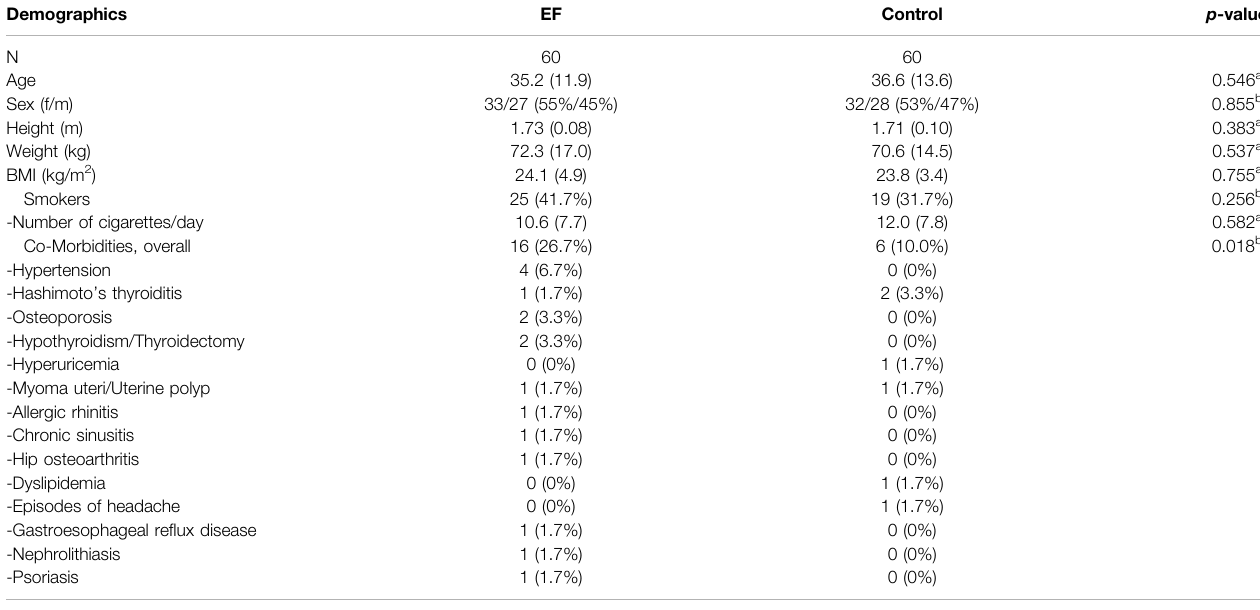
TABLE 1 | Demographics and co-morbidities.